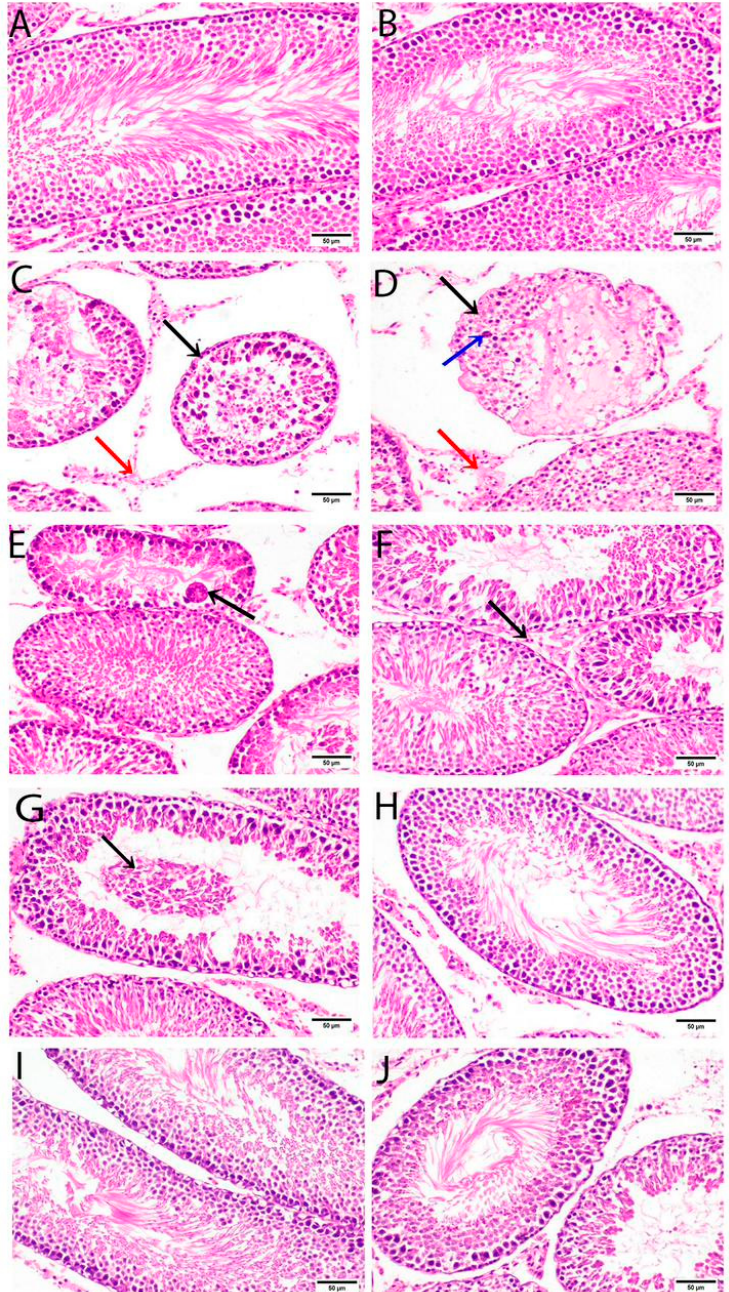
Figure 1. Testicular sections from all experimental groups were stained with hematoxylin and eosin (H&E; × 400; scale bar, 50 µ m). The testes of negative control rats ( A , B ) show a typical histological structure of seminiferous tubules with normal spermatogonia cells and complete